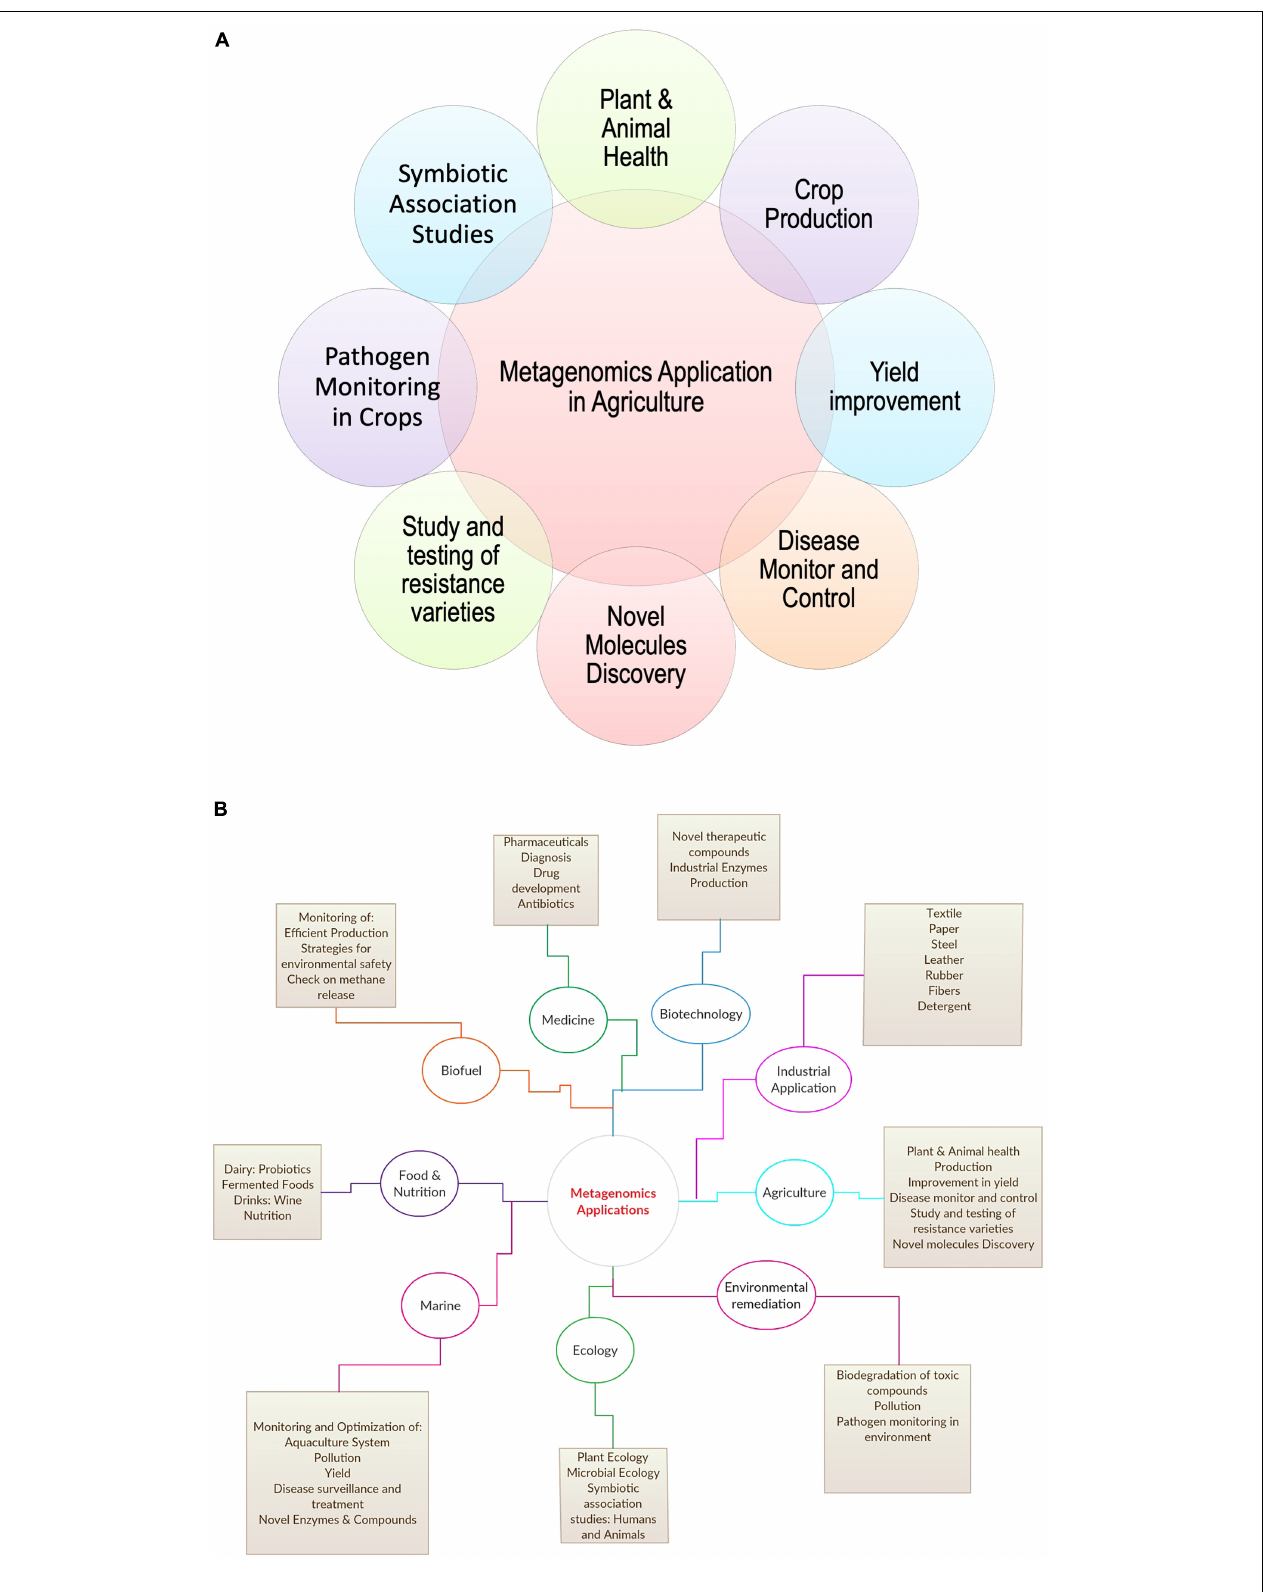
FIGURE 2 | Application of metagenomics in (A) agriculture and (B) other areas.